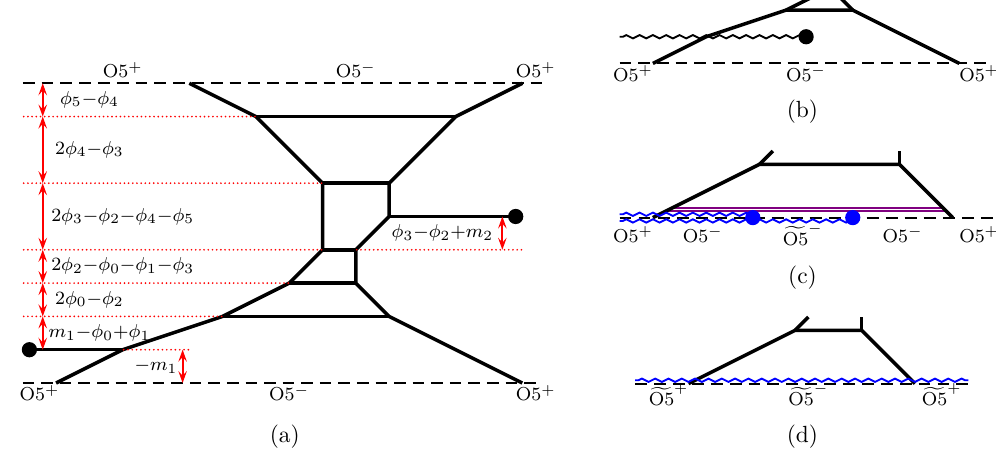
Figure 2. (a) Another 5-brane web for 6d SO(10) theory with two flavors after applying a series of flop transitions in figure 1. (b) The bottom part of (a) after applying Hanany-Witten transition. The black circle and black zigzag line denote D7-brane and corresponding monodromy cut, respectively. (c) Putting a D7-brane and a color D5-brane to the orientifold plane on the bottom. A D7-brane is − split into two half D7-branes and generates f O5 plane. The half D7-branes and corresponding half monodromy cuts are denoted by blue dots and blue zigzag lines. The half D5-brane is denoted by violet line. (d) A 5-brane configuration after Higgsing away two half D5-branes between D7-branes and then taking two half D7-branes to the left and right infinities,